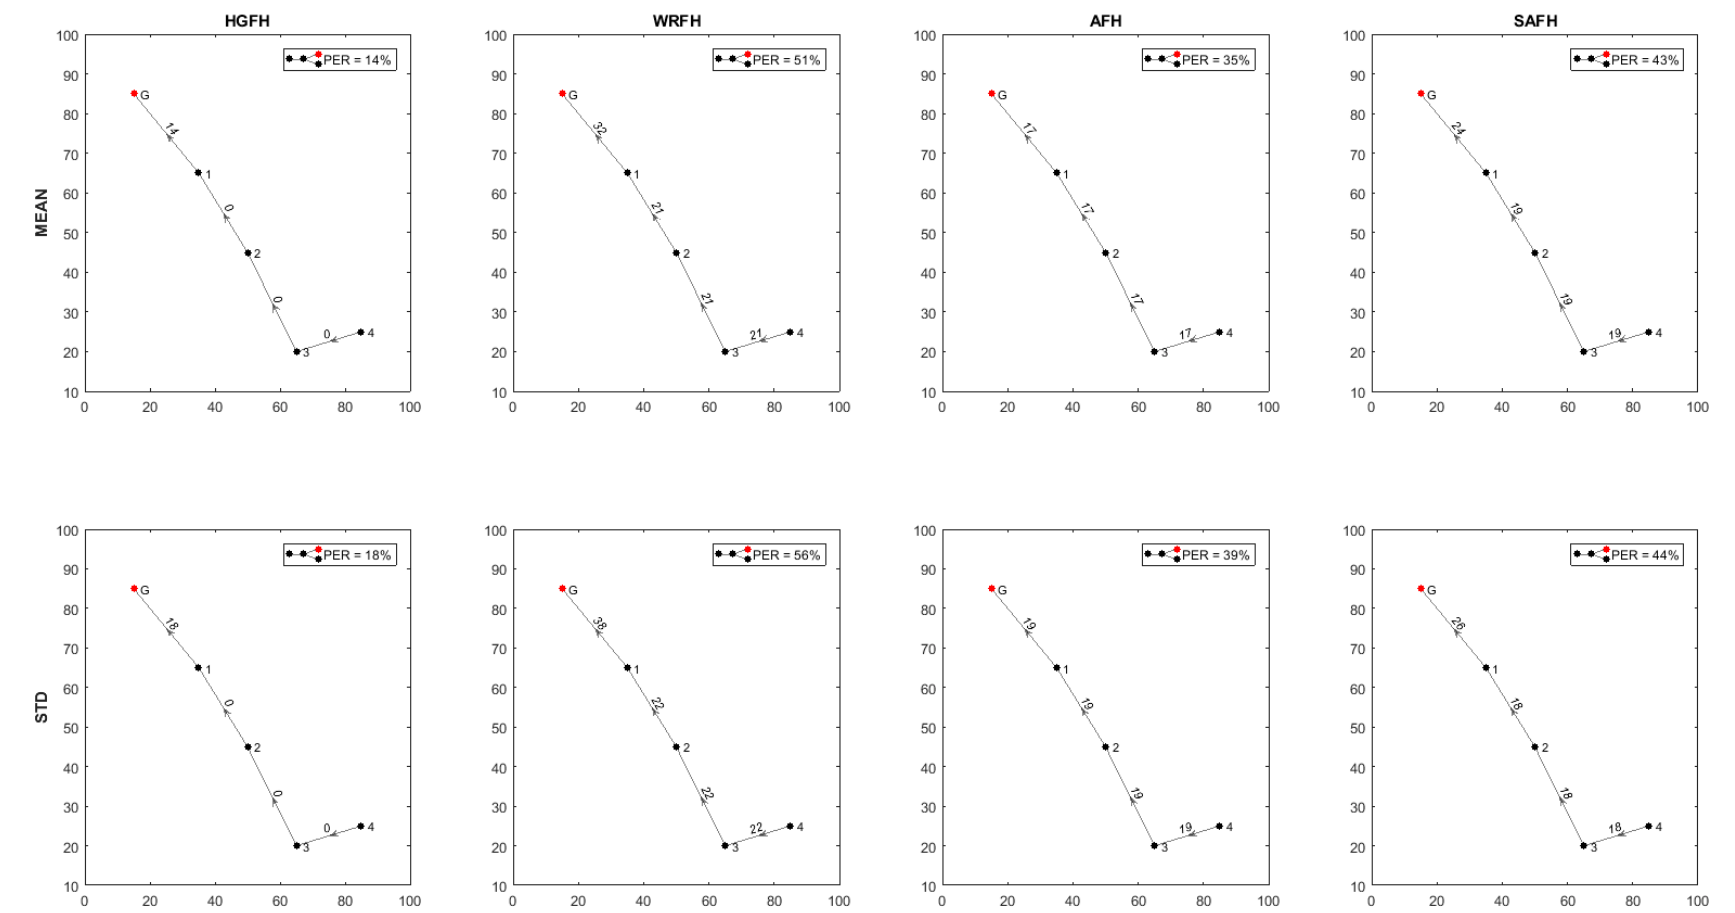
Figure 24. Inferred topologies with w PER = 0 and w DIST = 1. Minimizing the transmission distances results in multi-hop connections for all the hopping techniques and quality metrics. The overall PER is considerably increased, except for the HGFH technique, which remains the same as with single-hop topology.